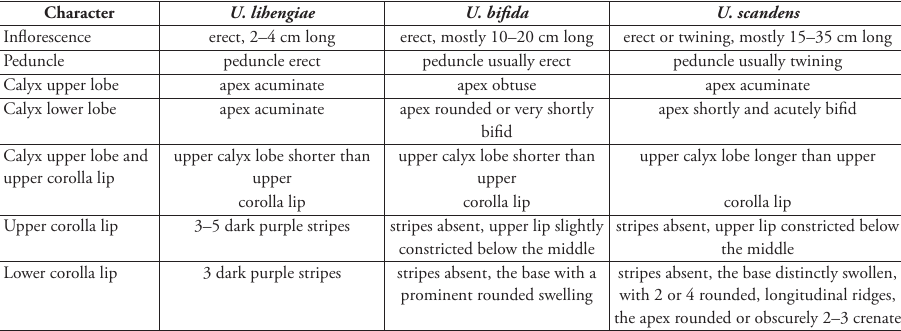
Table 1. Morphological comparison among Utricularia lihengiae , U. bifida , and U. scandens . Character Inflorescence